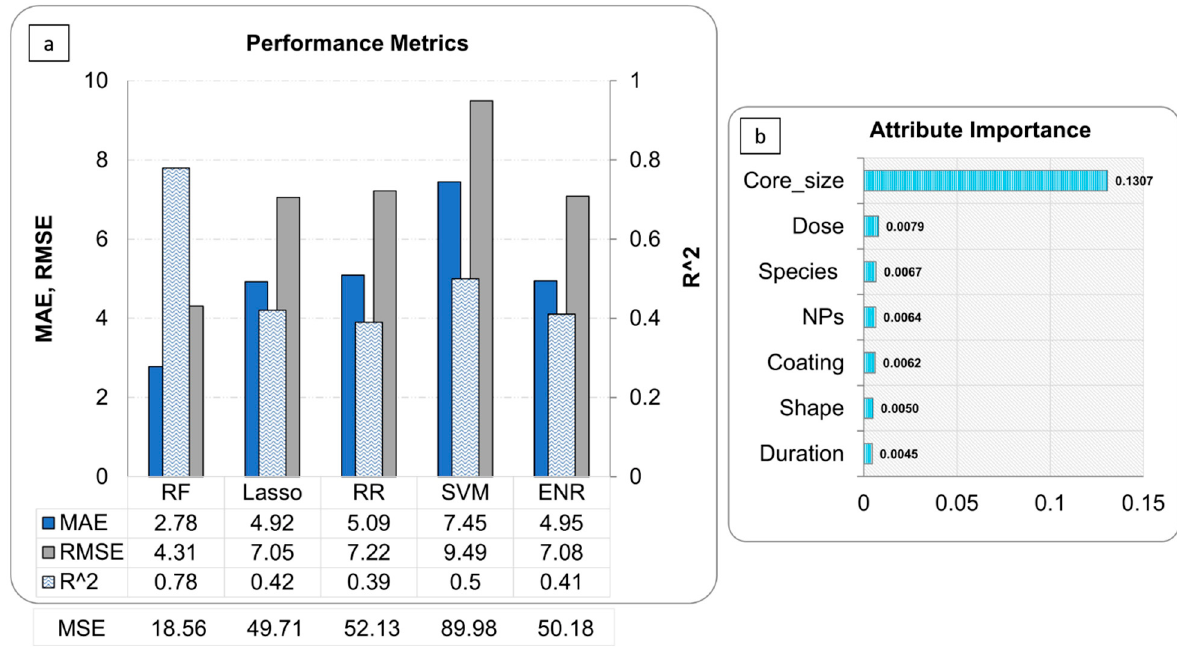
Figure 4. Performance metrics ( a ) and Random Forest Attribute Importance analysis results ( b ).